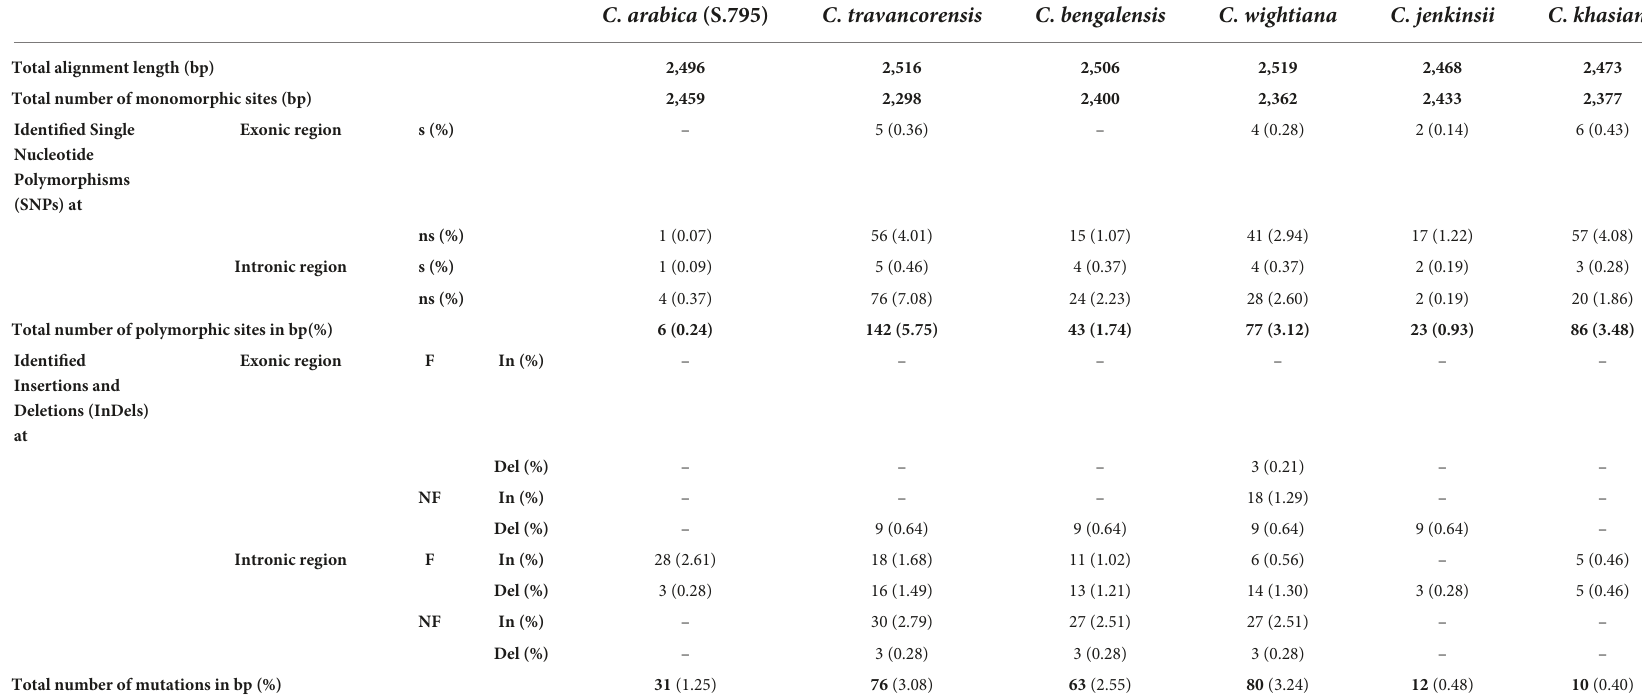
TABLE 3 Table depicting the sequence polymorphism and diversity of the NAC25 gene with reference to Coffea canephora